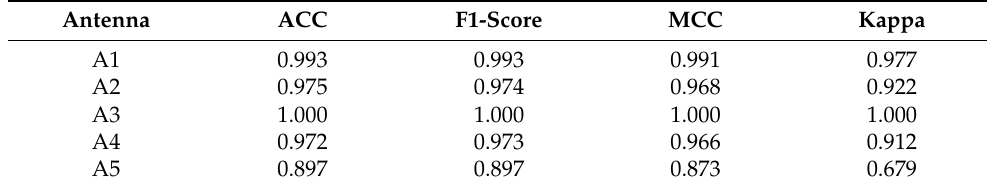
Table 8. Goodness parameters of the TREE algorithm applied to first MRMR